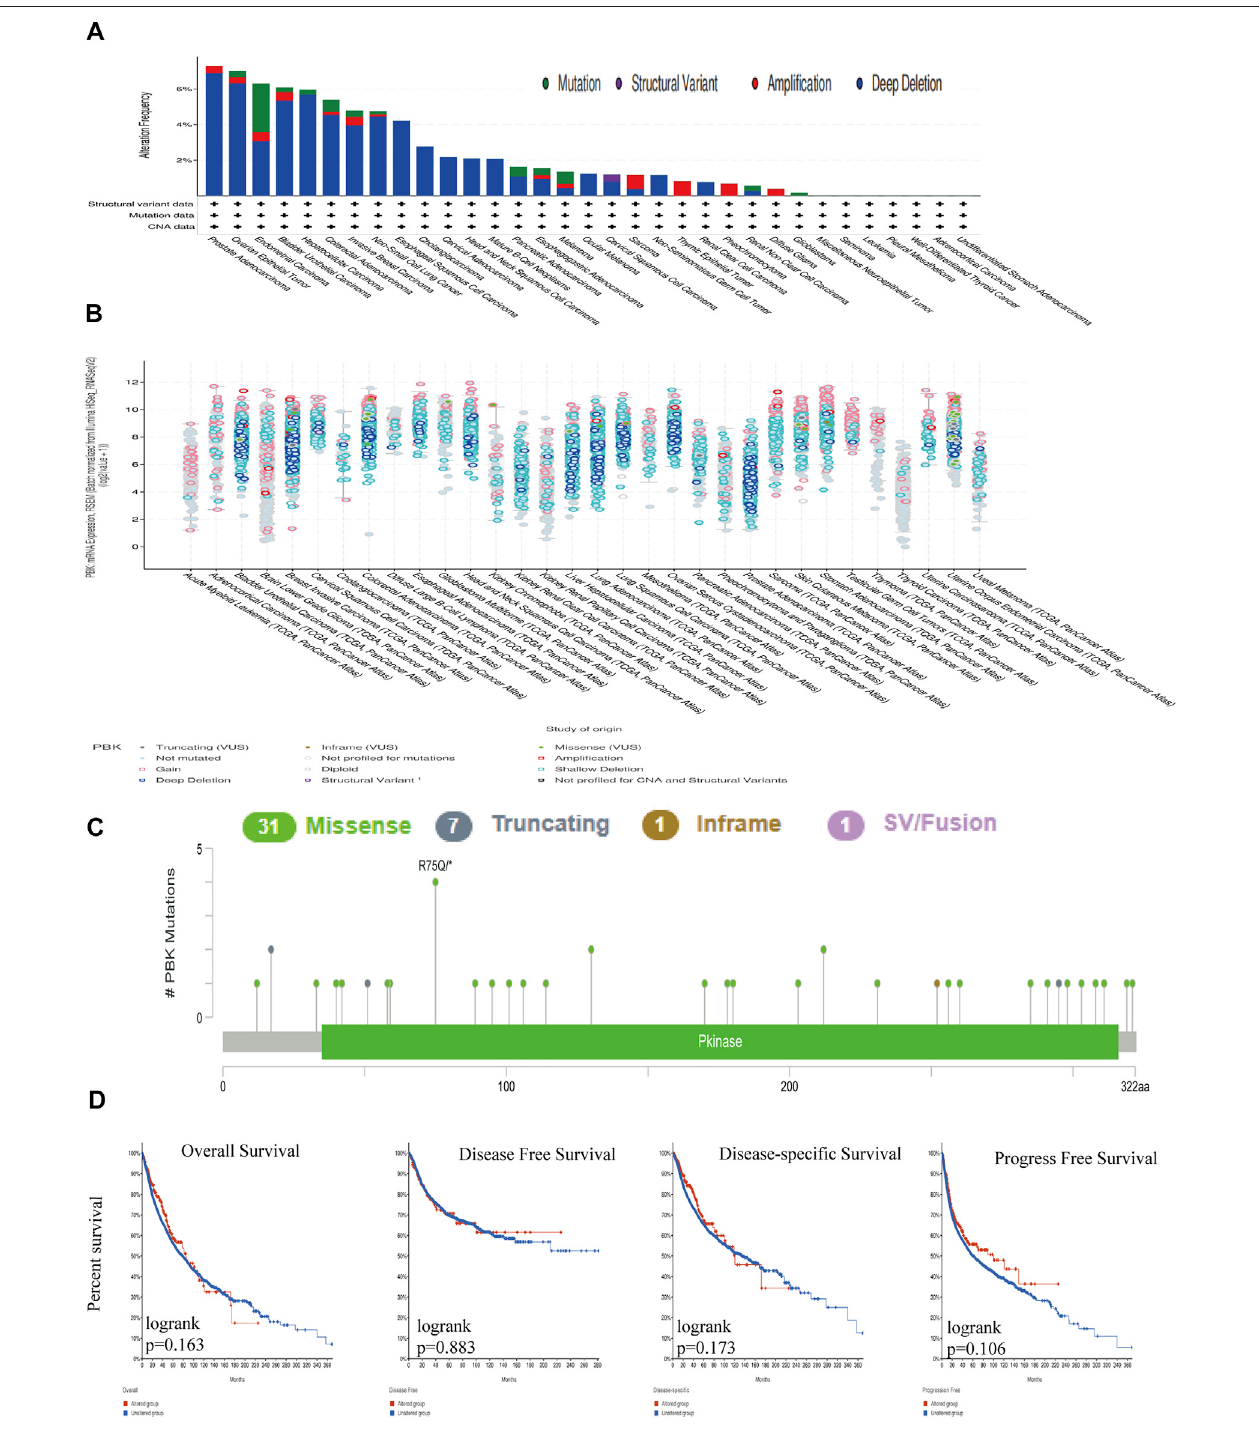
FIGURE2| GeneticalterationsinPBK. (A) PBKmutationfrequencyinmultipleTCGApan-cancerdatasetinthecBioPortaldatabase. (B) Overallmutationcountfor CD96invariousTCGA cancertypes inthecBioPortaldatabase. (C) MutationdiagramofCD96acrossproteindomains indifferentcancertypes. (D) OS,DSS,DFS,and PFS in cancers with genetic alterations in PBK.